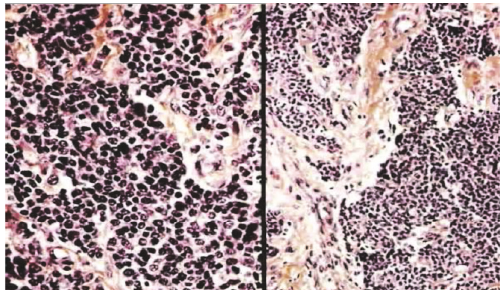
Figure 3: Neuroendocrine carcinoma of the breast (IHC; × 100): chromogranin A test positive for neuroendocrine tumor cells and negative for leukocyte markers (collection of the Pathological Anatomy Laboratory, the University Teaching Hospital of